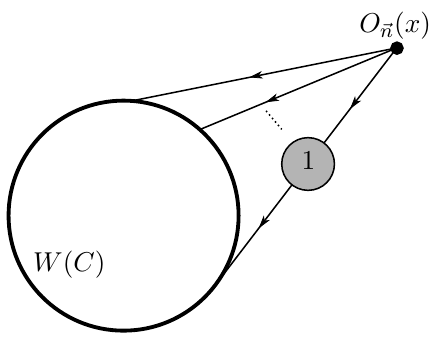
Figure 4 . The only diagrams that yield a g 2 correction to the tree-level amplitude A ~n and contain Q and H hypermultiplets arise from the one-loop correction of the external scalar propagators.